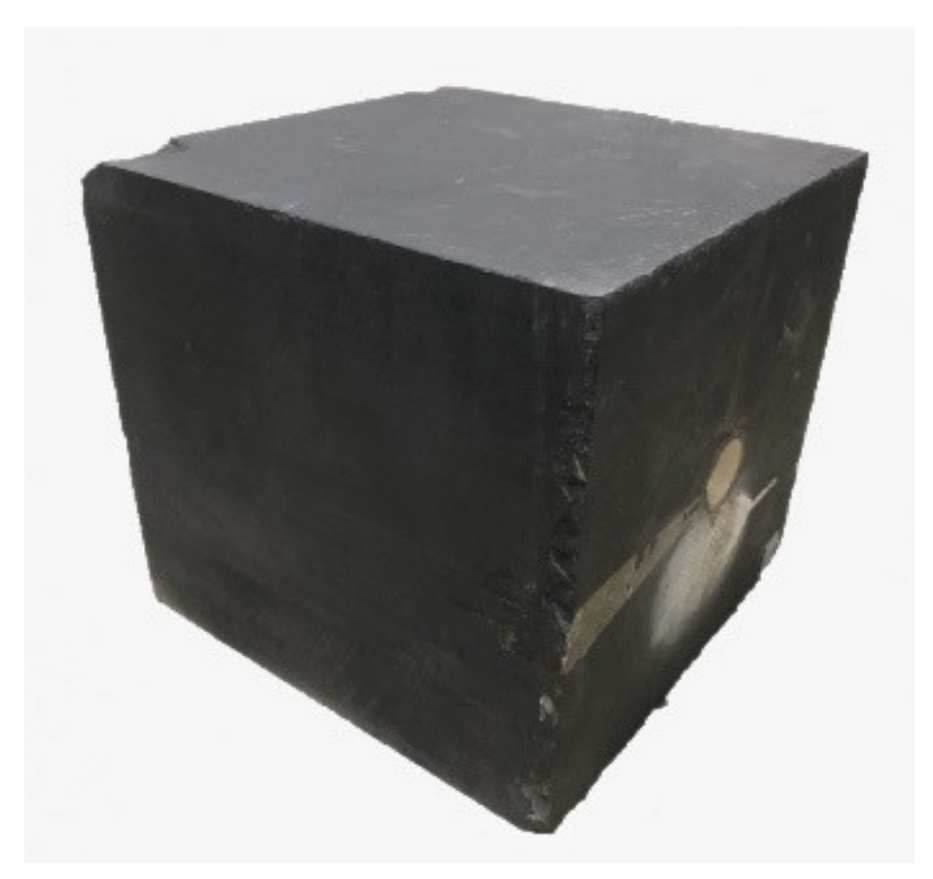
Figure 1. 30 cm × 30 cm × 30 cm cubic rock